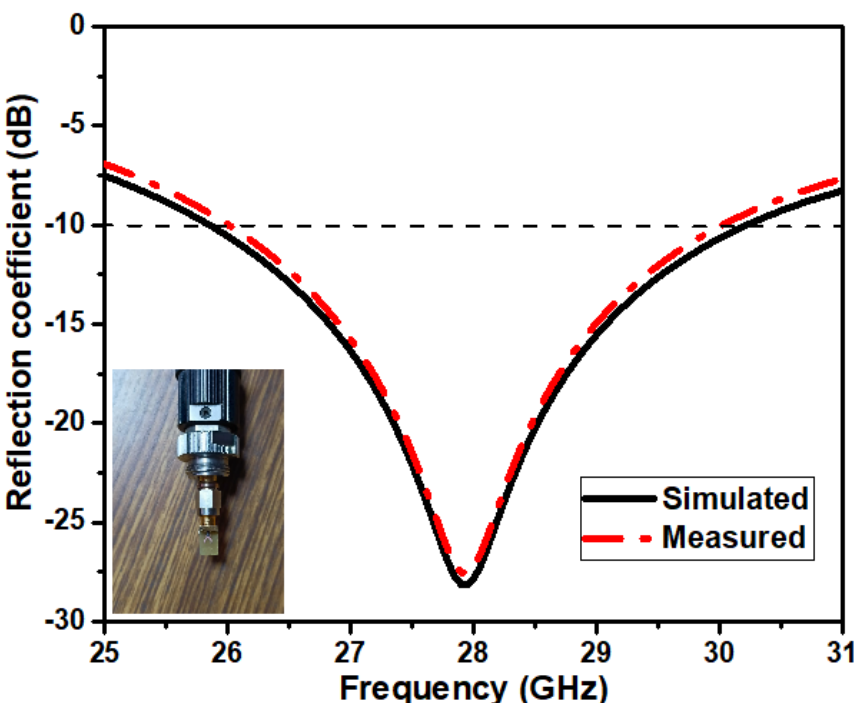
Figure 7. The simulated and measured S11 curve of the designed antenna.